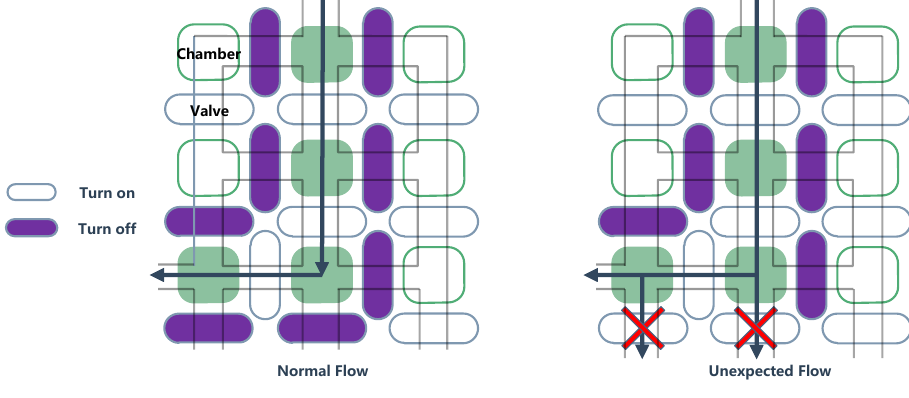
Figure 5. Normal flow and unexpected flow in the field-programmable gate array (FPVA)